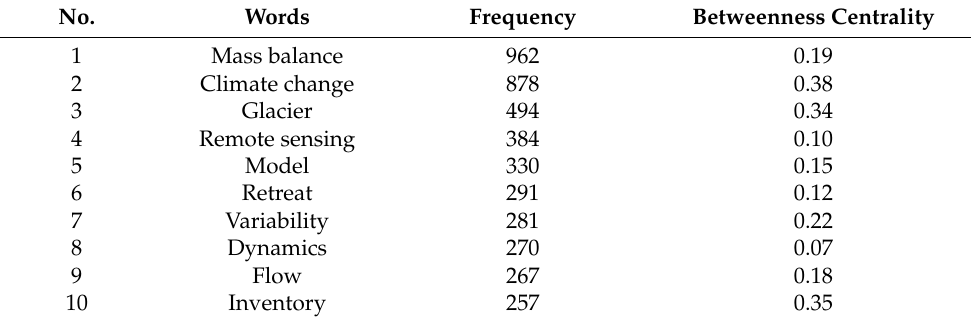
Table 8. Top 10 high ‐ frequency keywords.